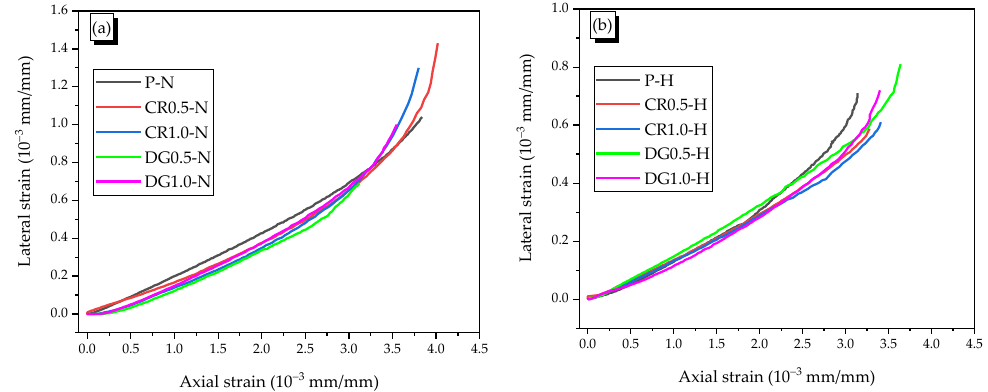
Figure 6. Typical axial–lateral strain curves, ( a ) Non-heating case, ( b ) Heating case.